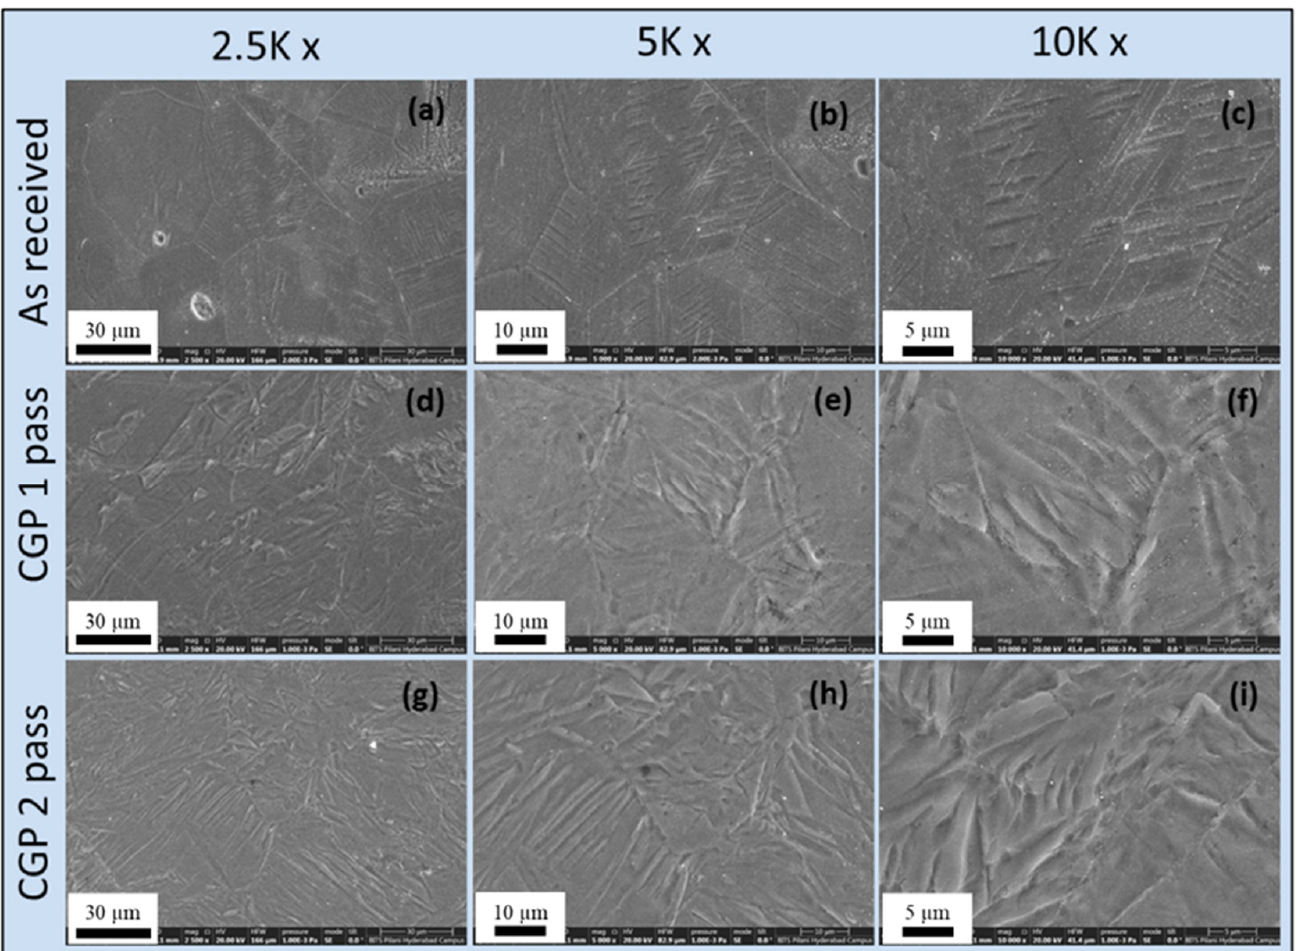
Figure 3. Scanning electron microscopy (SEM) images of ( a – c ) initial, ( d – f ) the first pass, and ( g – i ) the second pass of the constrained-groove-pressed Nitinol shape memory alloy at different magnifications, adapted with permission from [34], 2022, Elsevier.